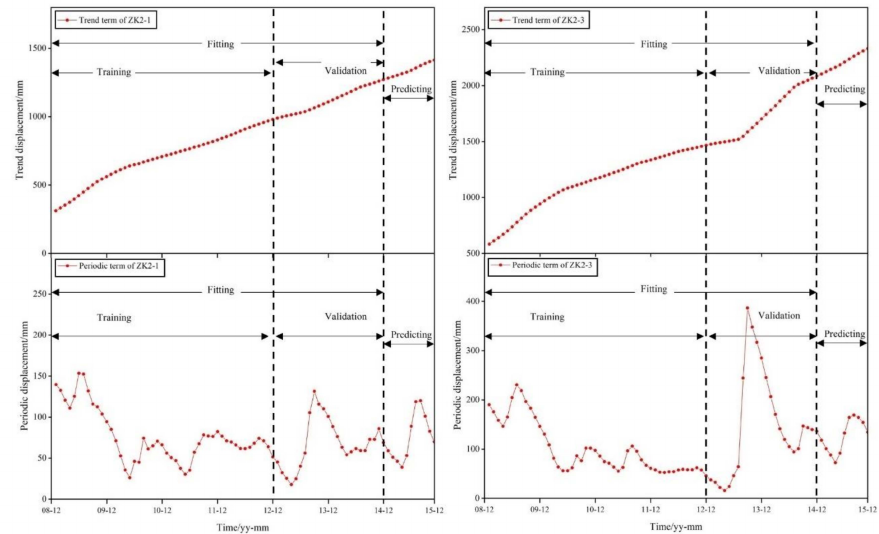
Figure 10. Trend and Periodic terms of ZK2-1 and ZK2-3 measurements in Shengjibao